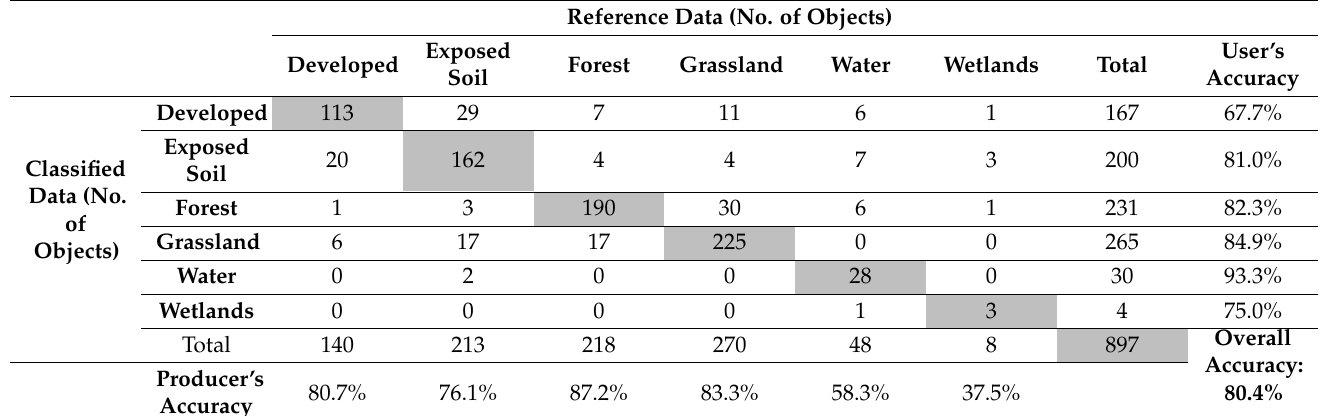
Table 7. Confusion matrix for an SVM-NC-Optimal classification of the North Carolina dataset trained from the small sample set ( n =